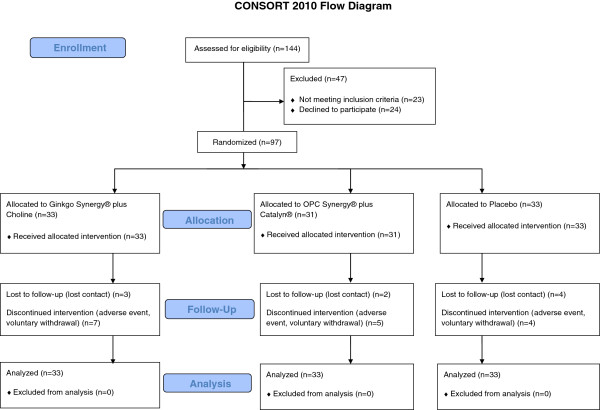
The CONSORT flowchart.